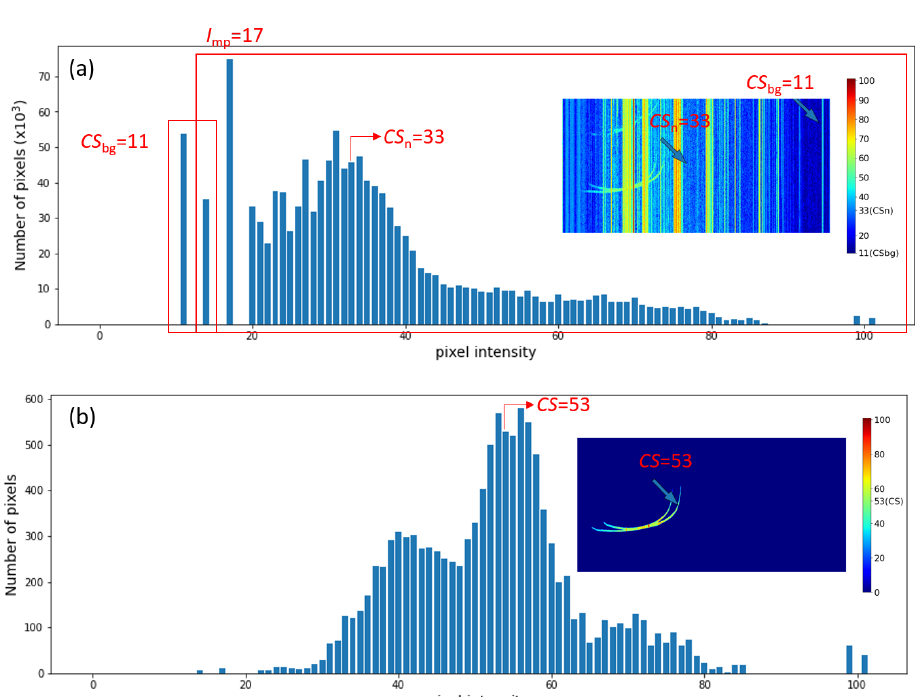
Figure 3. ( a ) The histogram of the pixel intensity I of the entire ionogram inserted on the right. ( b ) The histogram of the pixel intensity of the useful signal of the ionogram inserted on the